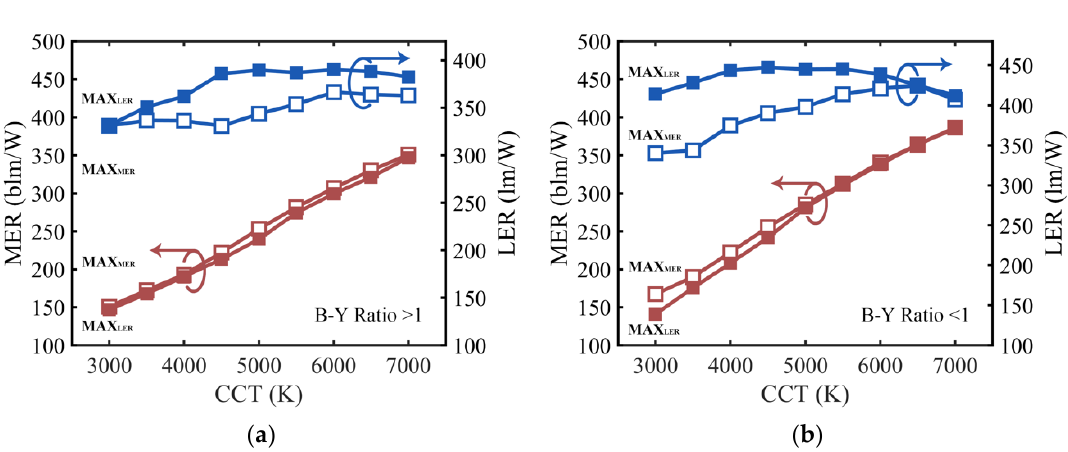
Figure 5. MER (y-axis on the left) and LER (y-axis on the right) as functions of correlated color temperature (CCT) under the LER-maximizing strategy and the MER-maximizing strategy with ( a ) B:Y ratio > 1 and ( b ) B:Y ratio < 1, where the red and blue solid lines with solid square markers represent MER and LER under the LER-maximizing strategy; the red and blue solid lines with hollow square markers represent MER and LER under the MER-maximizing strategy.